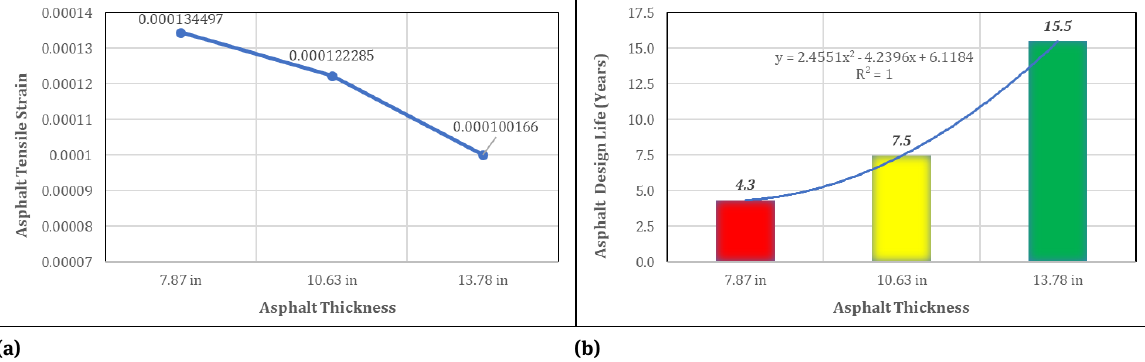
Figure 23: Influence of asphalt thickness on asphalt tensile strain (a) and on asphalt service life (b) in asphaltic overlayment rail track.